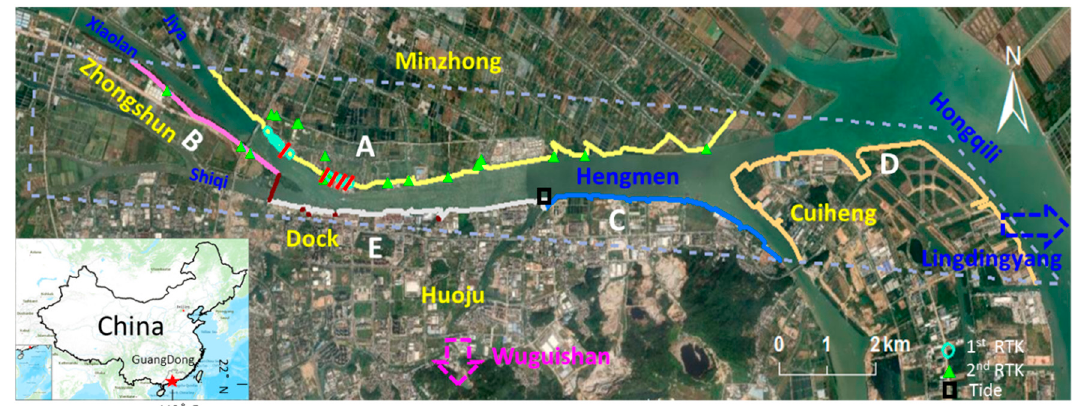
Figure 1. The airborne LiDAR surveyed areas (gray dashed line) in the Hengmen waterway of the Pearl River Delta, Zhongshan, Guangdong Province, China. The triangles, circles and red lines are the locations of in situ elevation measurement using GPS-RTK. The black square is the site of the Hengmen tidal station. The surveyed levees are divided into five segments from A to E.